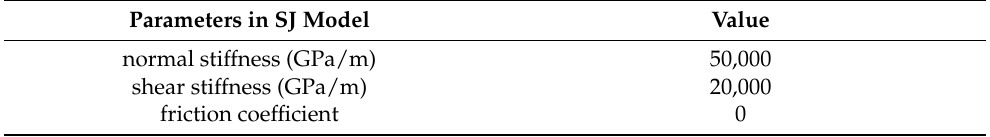
Table 4. Meso-mechanical parameters of smooth joint model for